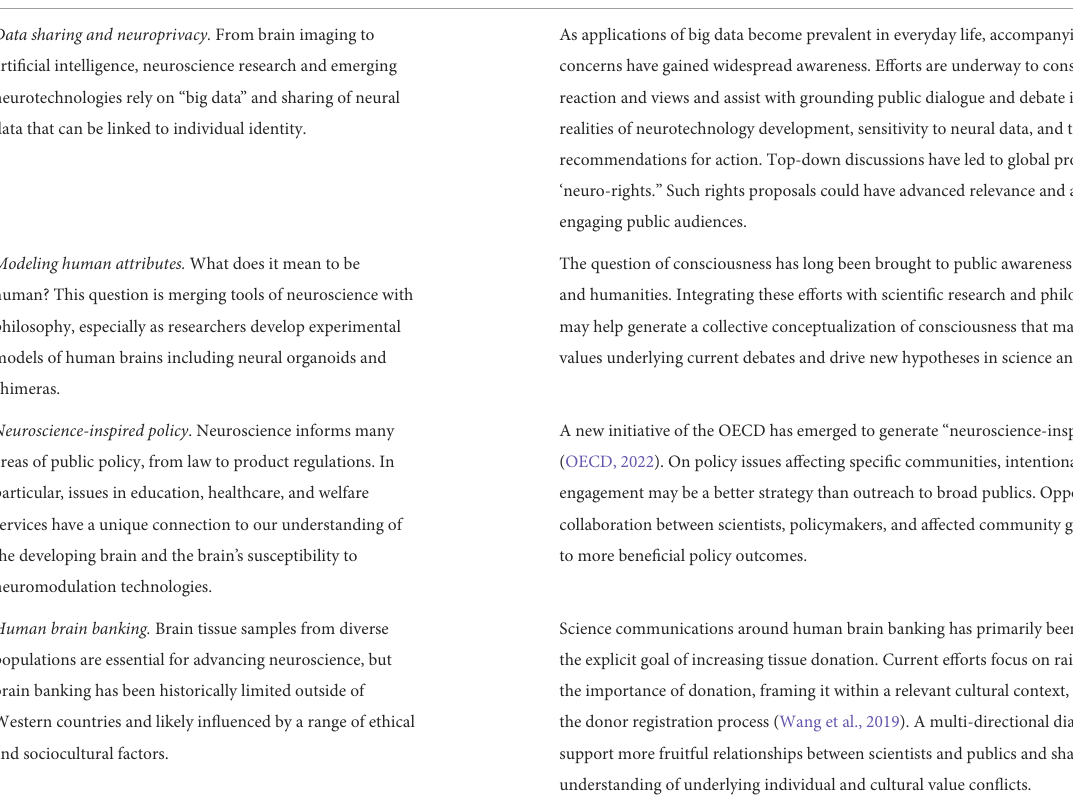
TABLE 1 Topical neuroscience issues and opportunities for neuroethics engagement. Topic Opportunities for neuroethics